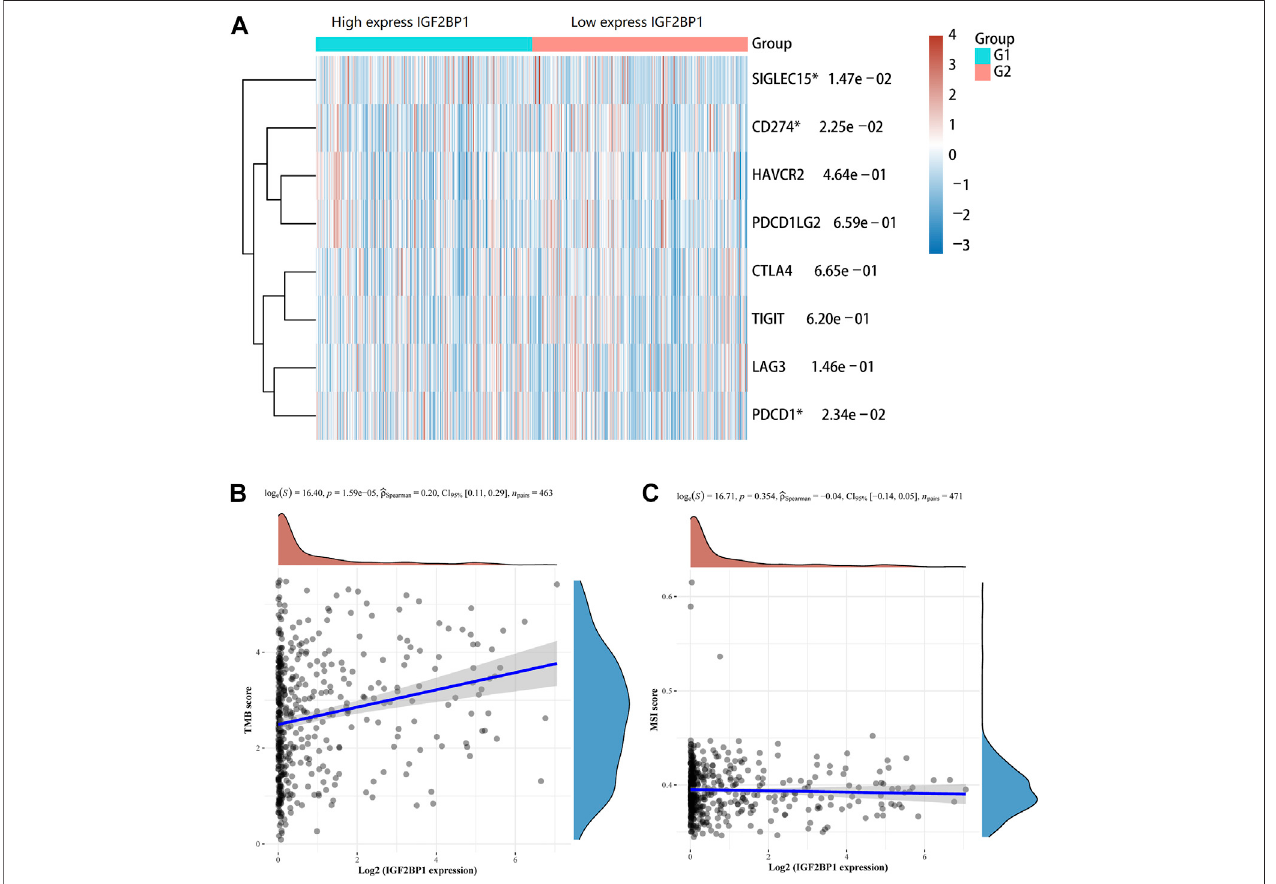
FIGURE 8 | Association of the IGF2BP1 gene with immune checkpoints, TMB, and MSI in LUAD. (A) Correlation of IGF2BP1 expression with immune checkpoint genes. (B) Correlation of IGF2BP1 expression with tumor mutational burden (TMB). (C) Correlation of IGF2BP1 expression with microsatellite instability (MSI).